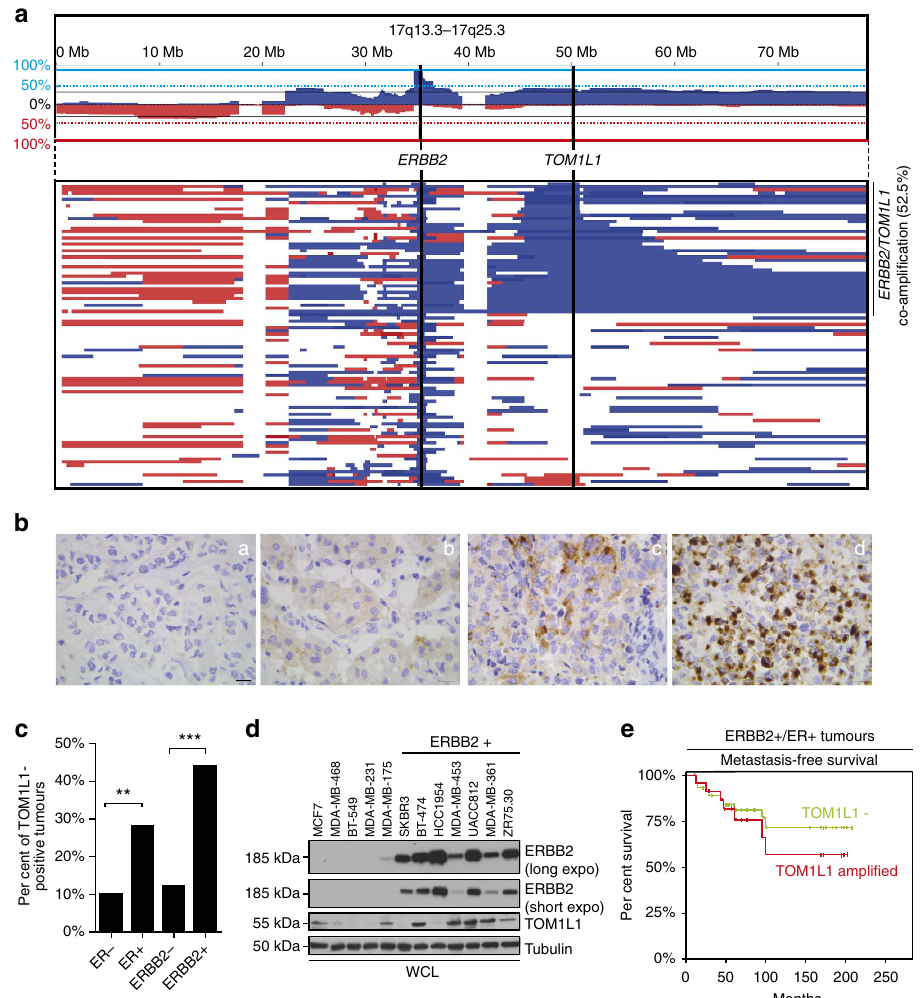
Figure 1 | TOM1L1 is co-expressed with ERBB2 in breast cancer. ( a ) The ERBB2 and TOM1L1 loci are frequently co-amplified in breast cancer. Upper part: cumulative array-CGH copy number frequency plots of chromosome 17 in breast tumours with ERBB2 amplification. Copy number gains are in blue, losses in red. Tumours with a log2 ratio higher than the threshold of 0.25 were considered as amplified. Lower part: copy number profiles at chromosome 17 in individual tumours (each line is one tumour). The colour code is the same as in the upper part. About 52.5% of ERBB2-positive tumours show TOM1L1 co-amplification. ( b ) Representative images showing TOM1L1 protein expression in breast cancer samples with absence (A), weak (B), moderate (C) and strong (D) immunoreactivity. Scale bar, 10 m m. ( c ) TOM1L1 expression was significantly associated with ER and ERBB2 expression. Histograms shows the results of screening by IHC of TOM1L1 expression in 108 breast tumours encompassing the four major subtypes (ER (cid:2) , ER þ , ERBB2 (cid:2) and ERBB2 þ ). Statistical analysis was done with Student’s t -test on raw data. ** P o 0.01 and *** P o 0.001. ( d ) TOM1L1 is overexpressed in ERBB2 þ cell lines. Western blot analyses of TOM1L1, ERBB2 and tubulin (used as loading control) expression in 12 breast cancer cell lines. ( e ) Kaplan–Meier survival analysis of patients with ERBB2 þ /ER þ breast cancer from the database of ref. 27. Patients were stratified based on TOM1L1 amplification (red curve) and were compared with patients with no amplification (green curve). The log-rank test was used to determine the statistical significance ( P value r